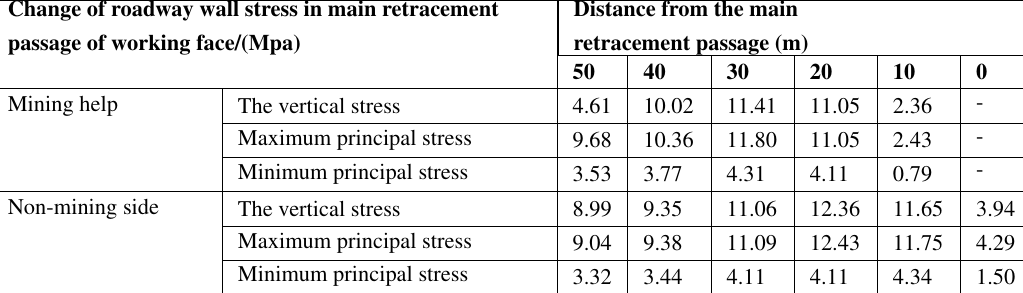
Table 1 Statistical table of roof settlement of working face Change of roadway wall stress in main